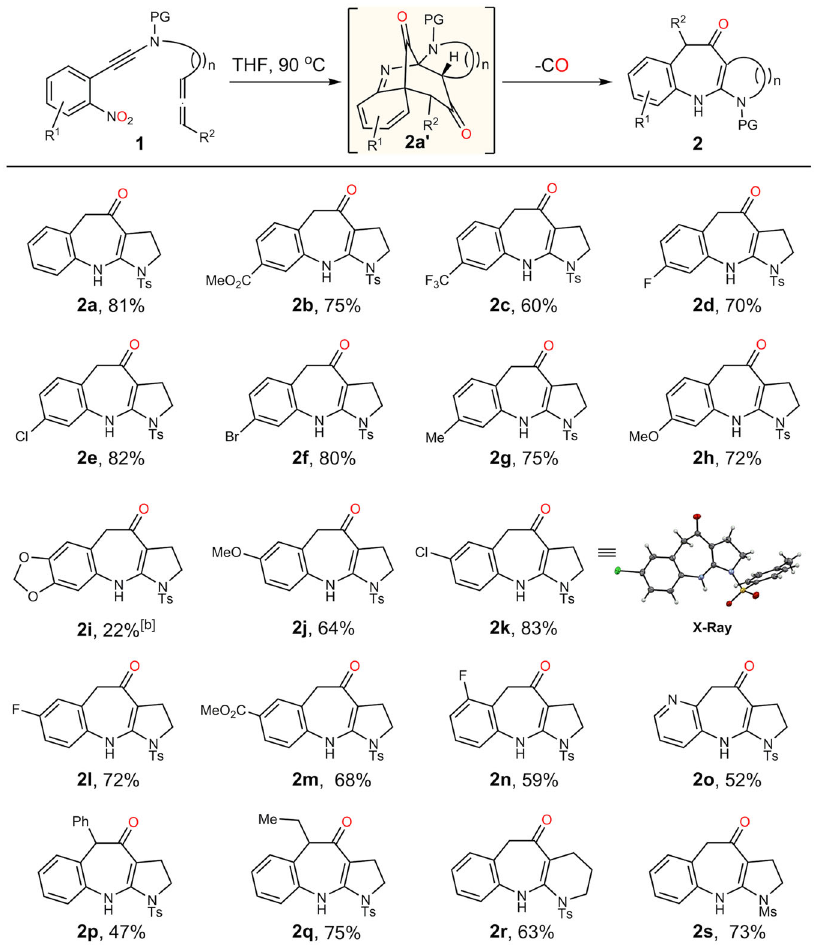
Fig. 3 | Evaluation of scope of benzazepines a . a Reaction conditions: The solution of 1 in THF (0.03M) was stirred under N 2 atmosphere at 90 o C for 6h. b Heating the resulting fi ltrate of 1 after the ynamide formation. PG=protective group. Ts = p -toluenesulfonyl. Ms = methanesulfonyl.